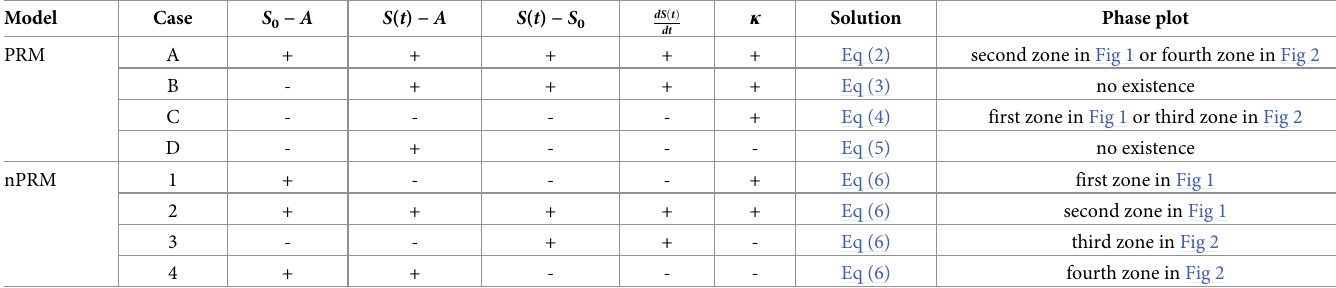
Table 1. Comparisons between solutions of PRM and nPRM under different conditions. Model